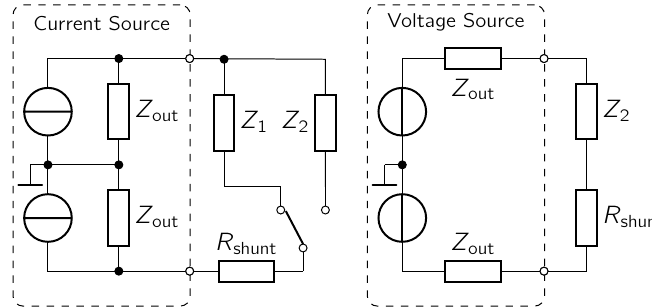
Figure 6: The current of both sources is differentially measured with a shunt